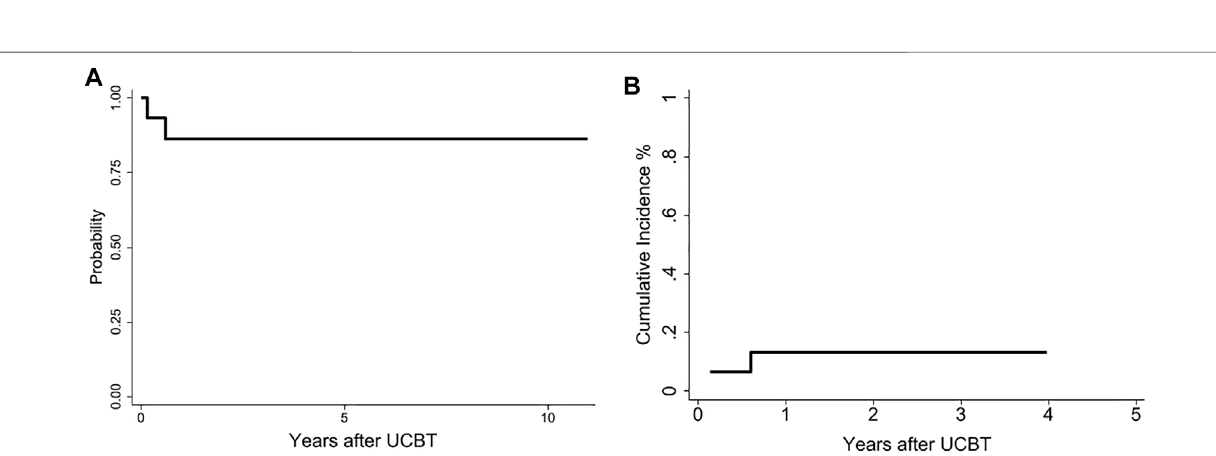
Frontiers in Cell and Developmental Biology |